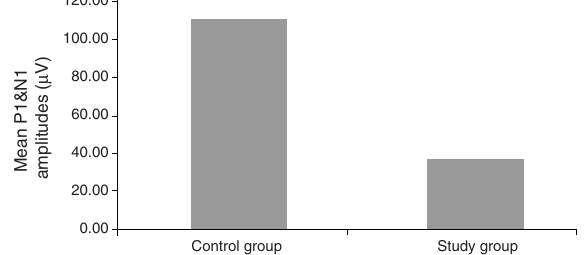
Mean P1 and N1 amplitudes of the study and control groups.